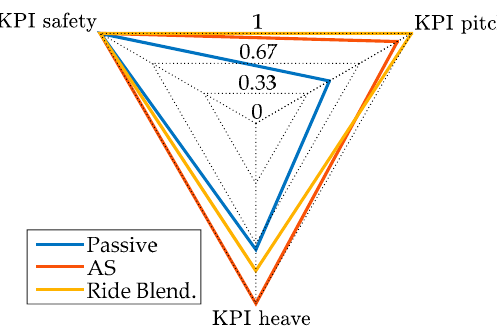
Figure 10. Key performance indexes improvement for the straight line braking maneuverer.